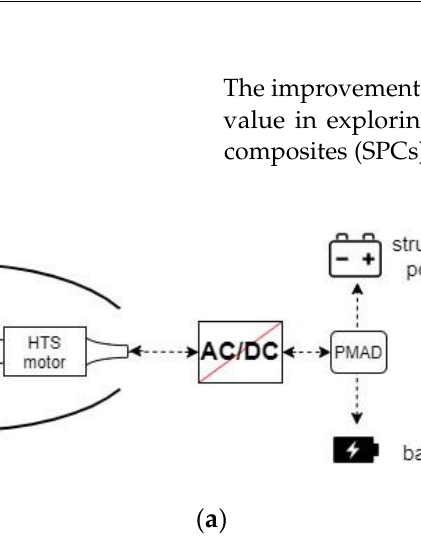
Figure 2. ( a ) Distributed propulsion ducted fan (adapted from [22,23], HTS = high-temperature superconducting, PMAD = power management and distribution system). ( b ) An all-electric aircraft with distributed propulsion designed in OpenVSP based on A320 design (adapted from [24]).